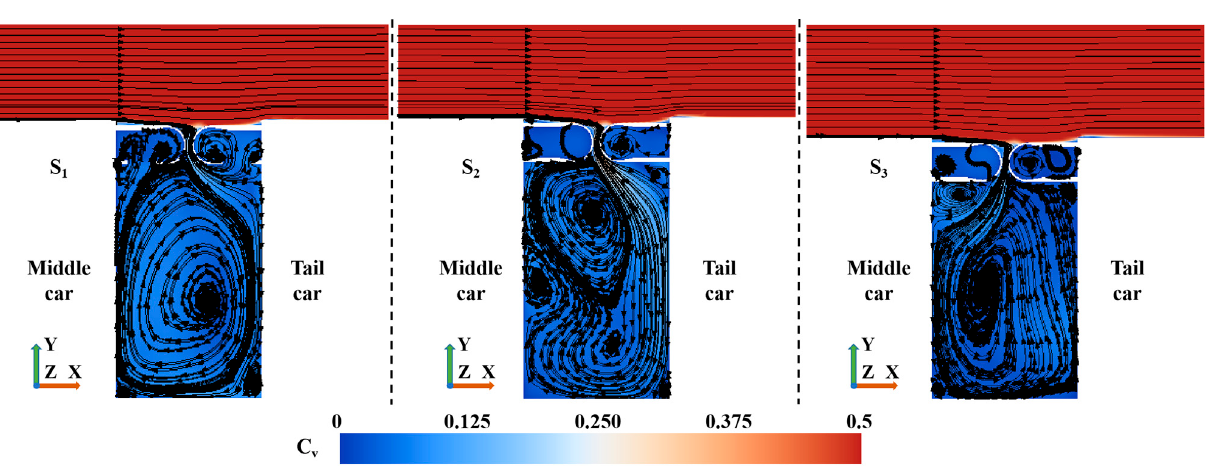
Figure 9. Pressure distribution of the windshield outer surface contour with different height sec- tions: ( a ) schematic diagram of the windshield outer surface contour, ( b ) W2 windshield, ( c ) W1 windshield.